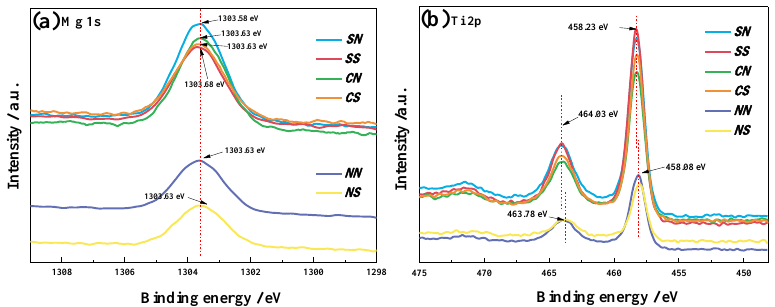
Figure 6. Mg 1s and Ti 2p spectra over titanium modified FeMgO x catalysts with different precursors. The Fe 2p spectra of titanium modified FeMgO x catalysts with different precursors are shown in Figure 7. The Fe 2p spectra consisted of three overlapping peaks, and the binding energy of the Fe species were further analyzed by peak-fitting. The Fe 2p 3/2 peaks at binding energy around 710.0 eV and 712.0 eV, the Fe2p 3/2,sat peaks at binding energy about 718.8 eV and the Fe 2p 1/2 peaks at binding energy of 724.2 eV were all ascribed to Fe 3+ [21].